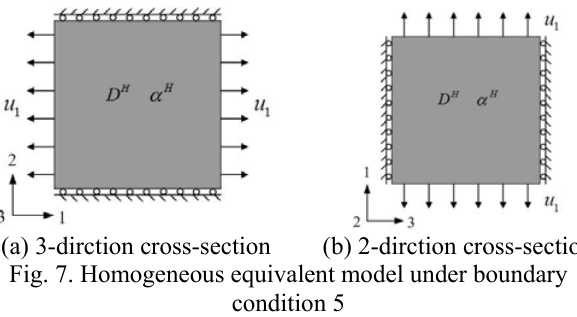
Fig. 6. Homogeneous equivalent model under boundary condition 1